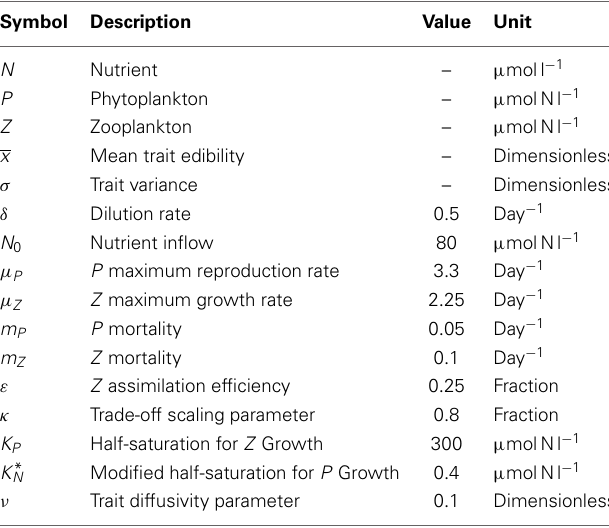
Table 1 | State variables and parameters used in the